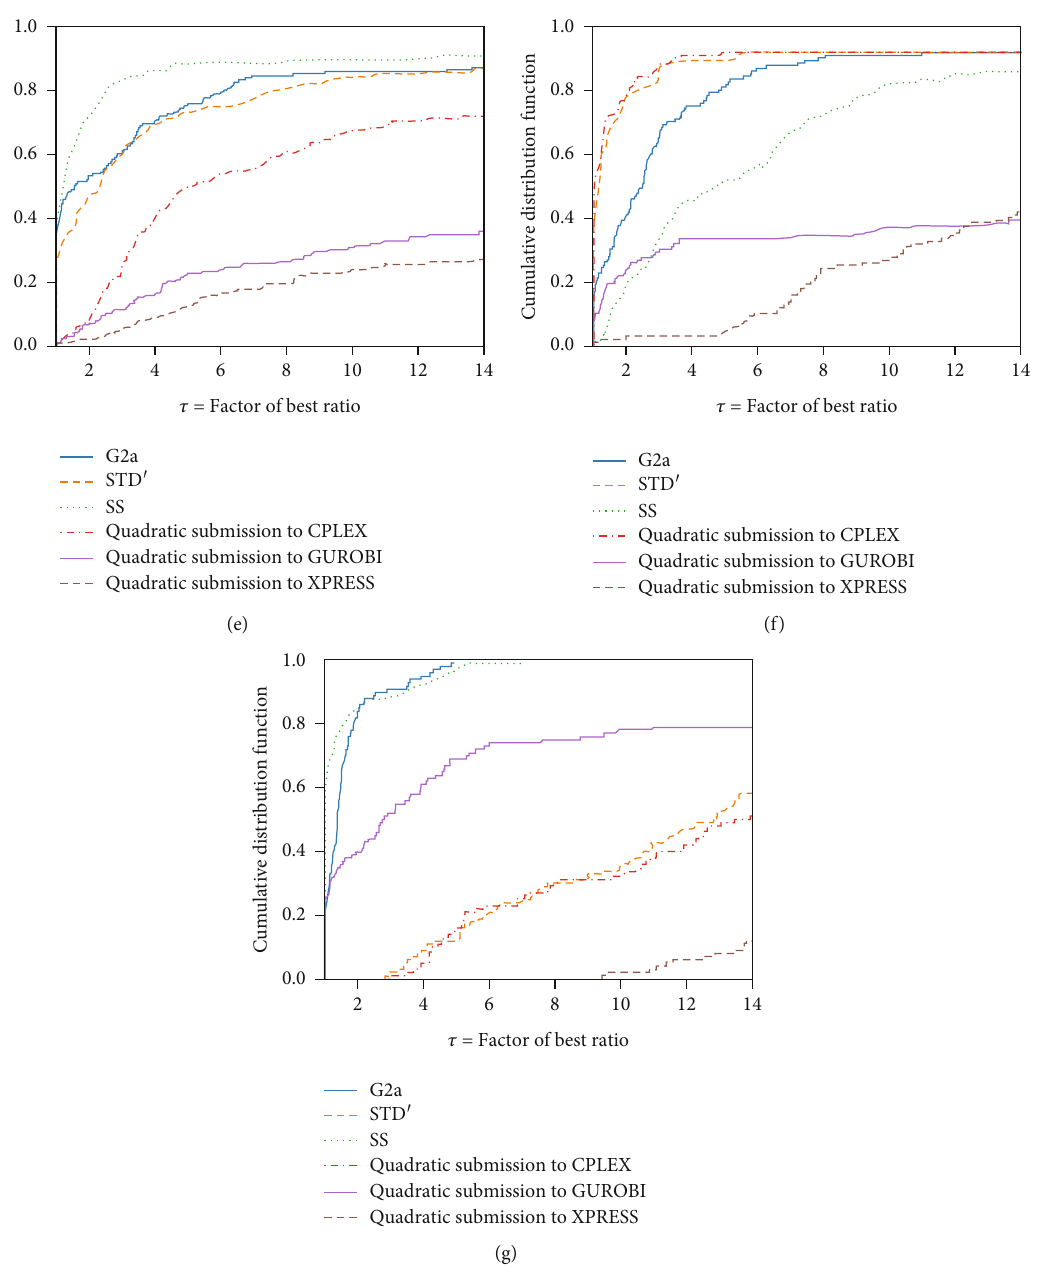
Figure 9: Performance pro fi les based on relative CPU time (s) for all approaches. (a) BLSP, (b) QMKP with positive coe ffi cients, (c) QMKP with mixed-sign coe ffi cients, (d) k QKP with positive coe ffi cients, (e) k QKP with mixed coe ffi cients, (f) HSP, (g)